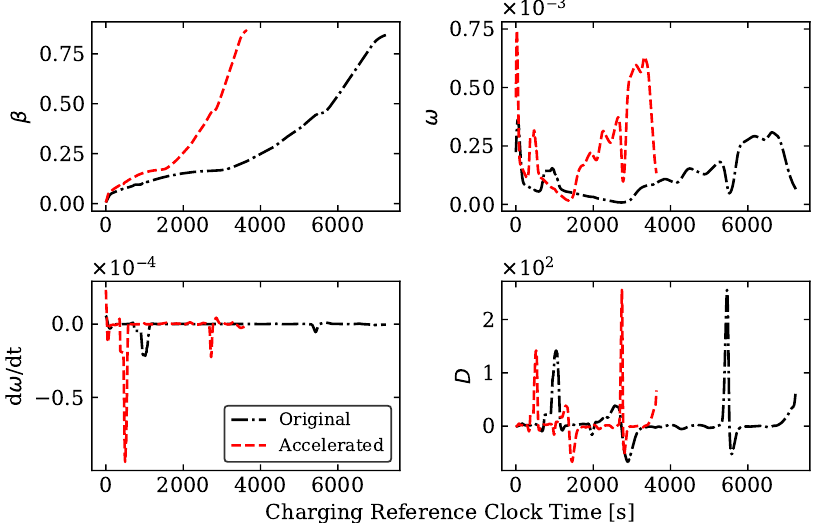
Figure 18. Comparison of charging mode at the outlet location, phase 1.